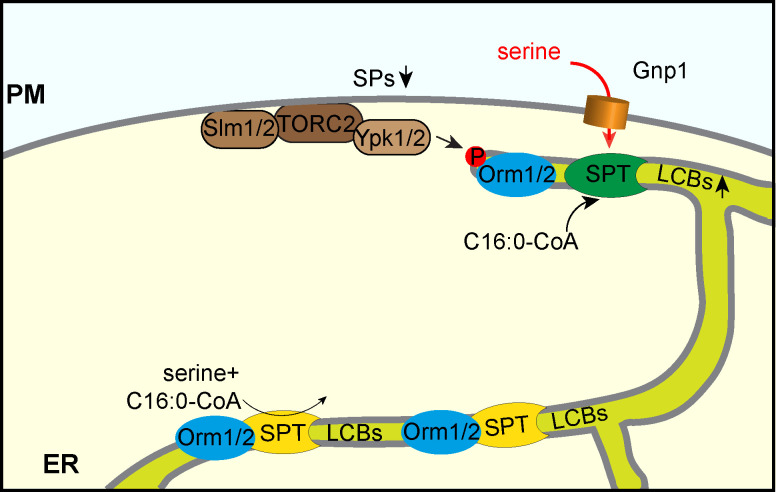
Model for direct coupling of Gnp1 mediated serine uptake and regulated SP biosynthesis.SP biosynthesis is directly coupled to Gnp1-mediated serine uptake. The SPT pool at the cortical ER is highly regulated by serine uptake and the TORC1/Ypk1/Orm1/2 signaling network. The nuclear envelope localized SPT pool is responsible for constant SP biosynthesis. This model adds serine uptake as another factor to previously described mechanisms regulating SP homeostasis by the signaling cascade of Slm1/2-TORC2-Ypk1/2 and the Orm proteins [7–9].